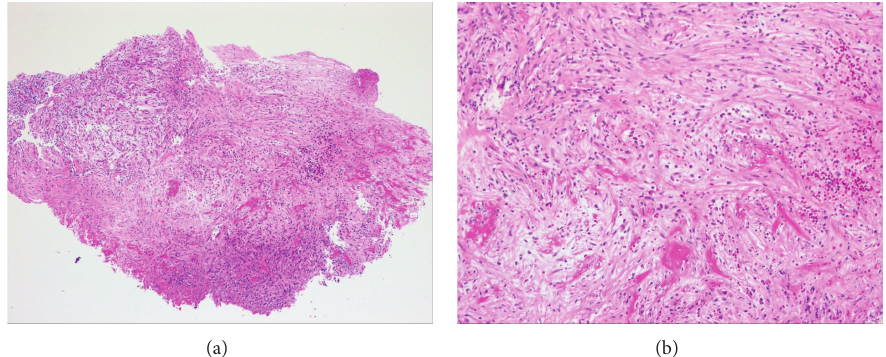
Figure 1: Preoperative histopathologic analysis of the polyp showing fibrinoid necrosis: (a) × 40; (b) × 100.